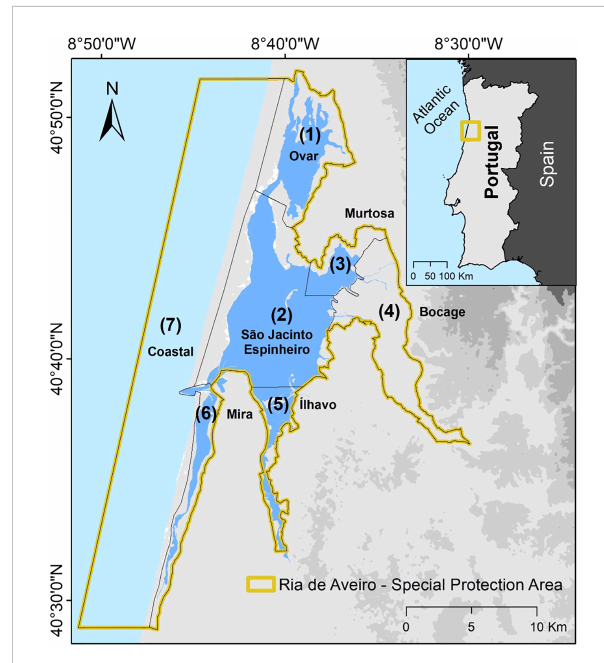
the water bodies (WB) from the EU Water Framework Directive as fi ve transitional WB and one group of coastal WBs. These six together with the terrestrial ‘ Bocage ’ landscape are de fi ned as landscape units in this study. They are shown in clockwise order: (1) Ovar - WB5, (2) São Jacinto-Espinheiro - WB2, (3) Murtosa - WB4, (4) Bocage - terrestrial, (5) I ́ lhavo - WB3, (6) Mira - WB1, (7) Coastal